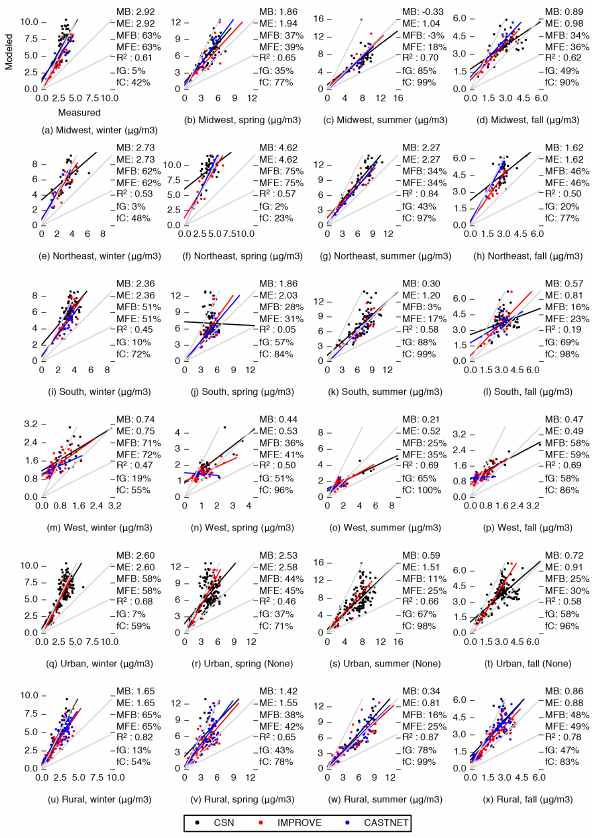
Figure 8. Comparison of modeled and measured particulate NH 4 concentrations, disaggregated by region and